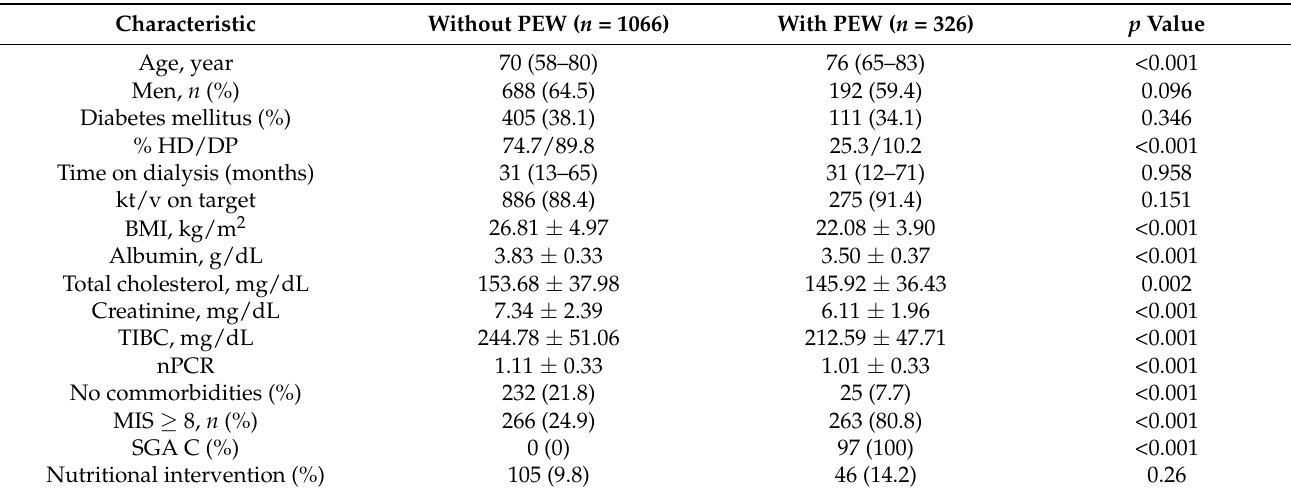
Table 1. Population characteristics according to the presence of